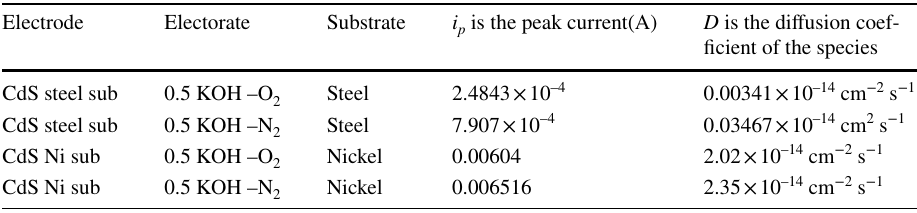
Table 3 Electrochemical characteristics of CdS-based